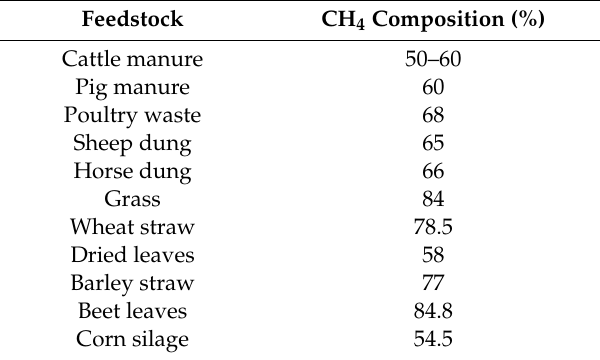
Table 3. Percentage composition of CH 4 from anaerobic digestion of various feedstocks